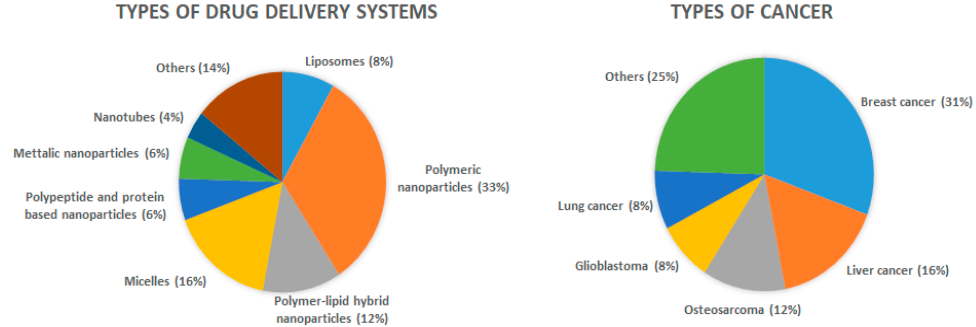
Figure 4. A summarized representation of the types of nanosystems ( left ) used in various cancer models ( right ), indicated as percentages of the studies reviewed herein.